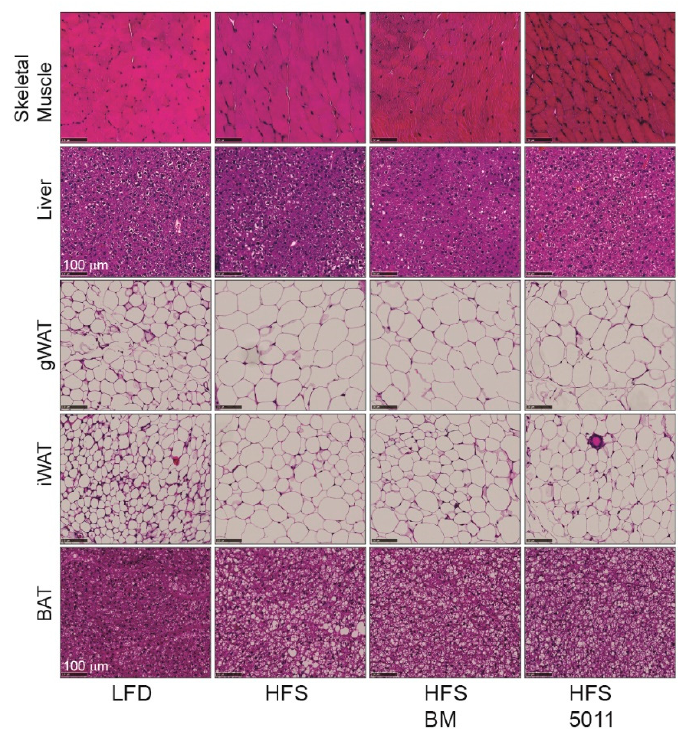
Figure 6. Tissue morphology of skeletal muscle, liver, white adipose, and brown adipose tissues shown by hematoxylin and eosin staining. Lipid accumulation in skeletal muscle was not higher in the HFS diets compared to the LFD. A small increase in hepatic lipid content with the HFS was attenuated by botanical supplementation. Lipid accumulation in perigonadal (gWAT) and inguinal (iWAT) white adipose tissue was increased by adipocyte hypertrophy in all HFS-fed groups. Brown-fat lipid accumulation occurred in unilocular and multilocular lipid droplets in the females fed the HFS diet but was unilocular and multilocular droplets in the HFS alone diet and predominantly multilocular lipid droplets in the botanical supplemented HFS-fed diets. The images are representative of images from four mice/group. The black bar length represents 100 μ m.